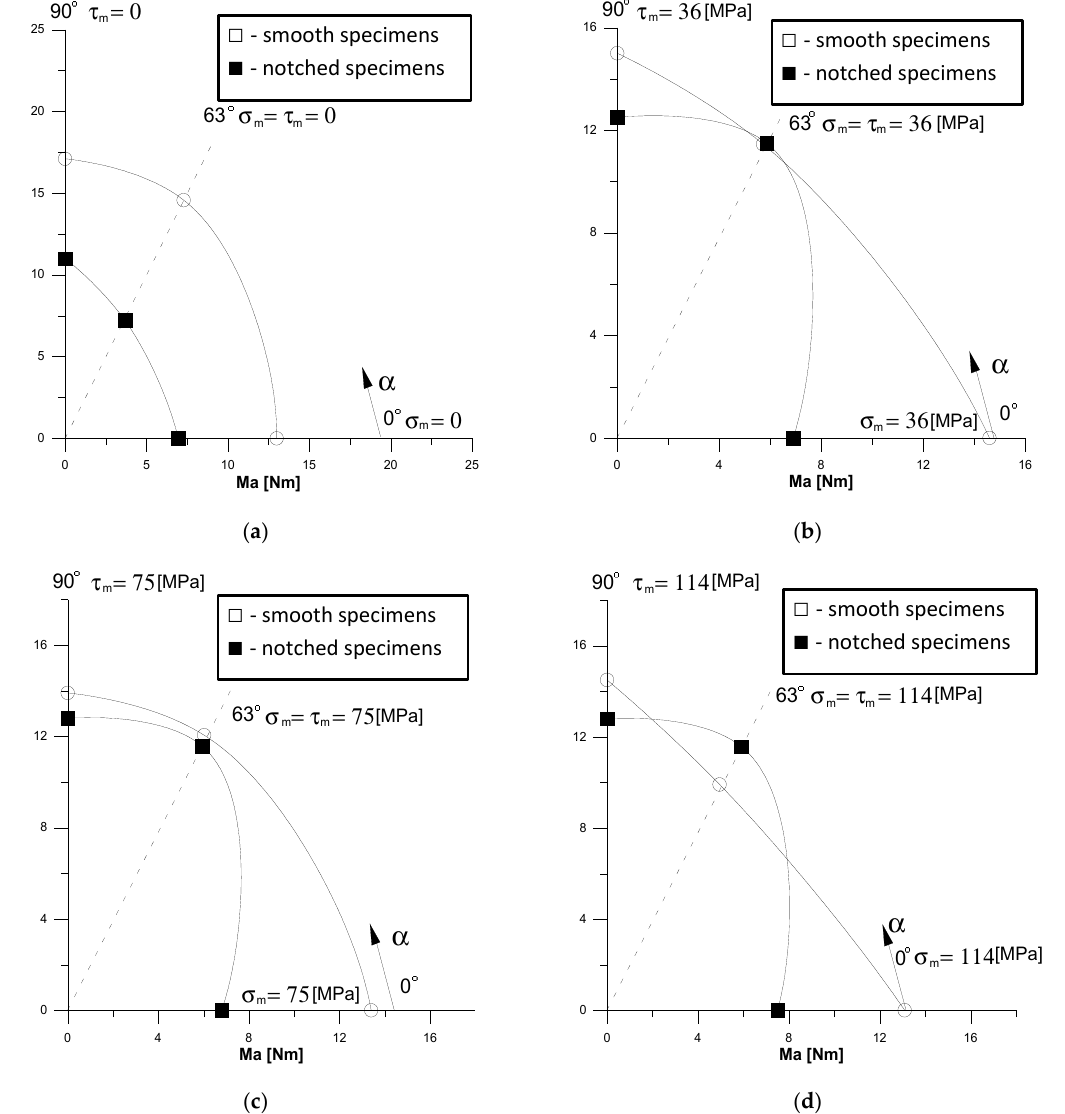
Figure 8. Amplitudes of moments at the level close to the fatigue limit (N = 10 6 cycles) depending on angle α and mean stress level: ( a ) 0, ( b ) 75 MPa, ( c ) 150 MPa, ( d ) 225 MPa